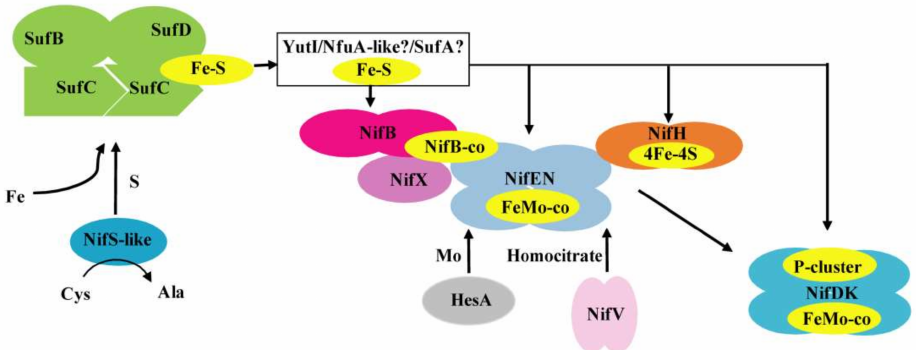
Figure 7. A model of Fe–S cluster biosynthesis of nitrogenase in P . polymyxa WLY78. The SufBCD complex acts as a scaffold complex receiving sulfur from NifS-like and iron from a still unknown donor. YutI (possibly work with SufA or/and NfuA-like) is as an Fe–S carrier that may receive an Fe–S cluster from the SufBCD scaffold and transfer it to nitrogenase component proteins. The model shows in yellow the Fe–S cluster. The 4Fe–4S cluster is inserted into apo-NifH to activate it. Simple Fe–S clusters were reconstituted on NifB and are converted into NifB-co. NifEN binds NifB-co and converts it into FeMo-co. HesA and NifV provide Mo and homocitrate. NifX may assist NifB, NifEN, and NifDK in FeMo-co precursor trafficking. The FeMo-co and in situ assembly of the P-cluster are inserted into apo-NifDK to form